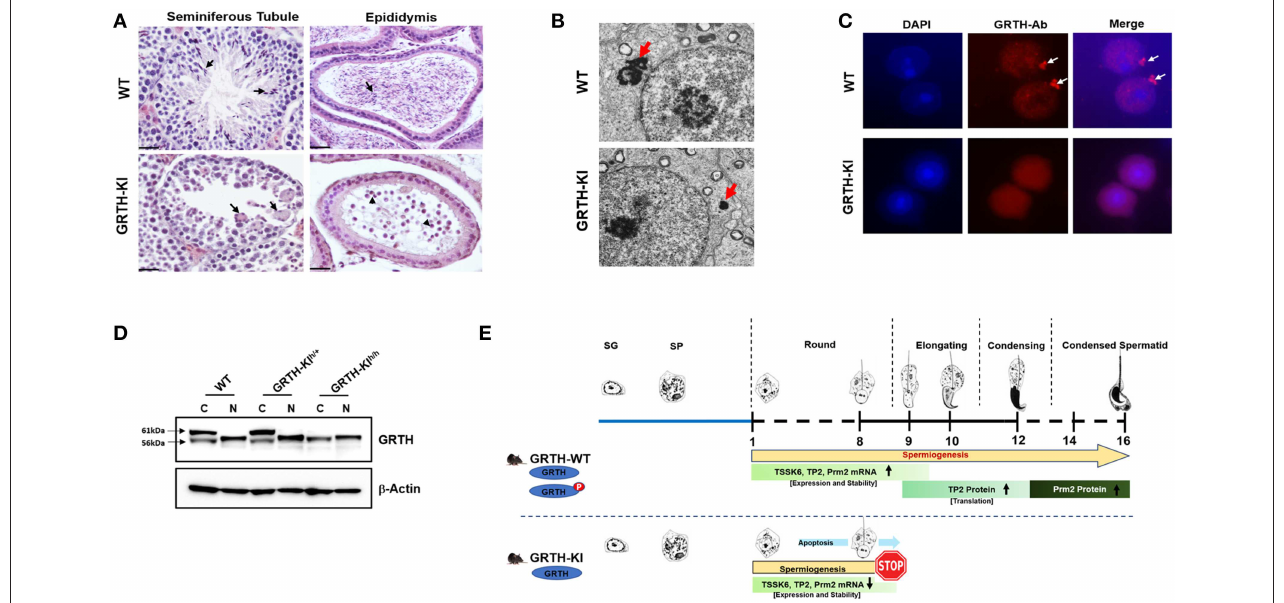
FIGURE 4 | GRTH-KI and essential role of phospho-GRTH in round spermatid during spermiogenesis. (A) H&E staining of WT and GRTH-KI mice testis showing seminiferous tubules and epididymis. In WT mice seminiferous tubules arrows indicate presence of elongated spermatids. GRTH-KI show degenerating multinucleated giant cells indicated by arrows. Epididymis of WT mice is filled with mature sperm (indicated in arrows) while in KI mice lack sperm but the lumens contain degenerating germ cells (indicated in arrowheads). (B) EM sections testis showing marked size reduction in chromatoid body (CB) in round spermatids (red arrows) of GRTH-KI mice compared to WT mice. (C) Immunofluorescence staining of GRTH protein (Red) in the nucleus and at cytoplasmic sites, in chromatoid bodies (CB) of round spermatids of WT mice (39). Arrows indicate CB. GRTH-KI mice lack GRTH signal in the CB. Nuclear staining using DAPI is shown in blue. (D) Western blot showing non-phospho GRTH expression in WT, heterozygous and homozygous KI mice while pGRTH expression was totally absent in homozygous KI mice compared to WT mice and heterozygous KI mice (39). (E) Schematic diagram showing progression of mice spermatogenesis from spermatogonia to round spermatids which undergo different steps (total 16) of development to give rise to a condensed sperm. In WT mice during the process of spermiogenesis in round spermatids we observed stable expression of Tssk6, Tp2, and Prm2 mRNAs and phospho-GRTH plays an important role in the stability of these germ cells specific mRNAs until ready for translation in later steps during elongation of spermatids. During spermatid elongation transition proteins are replaced by protamines1/2 and the chromatin becomes more condensed. While in GRTH-KI mice due to lack of phospho-GRTH the stability of above-mentioned germ cells specific mRNAs is hampered resulting in their reduced mRNA levels and degradation. In GRTH-KI mice Tp2 and Prm2 proteins are absent due to failure of round spermatids to elongate in step 8 of spermiogenesis (39).